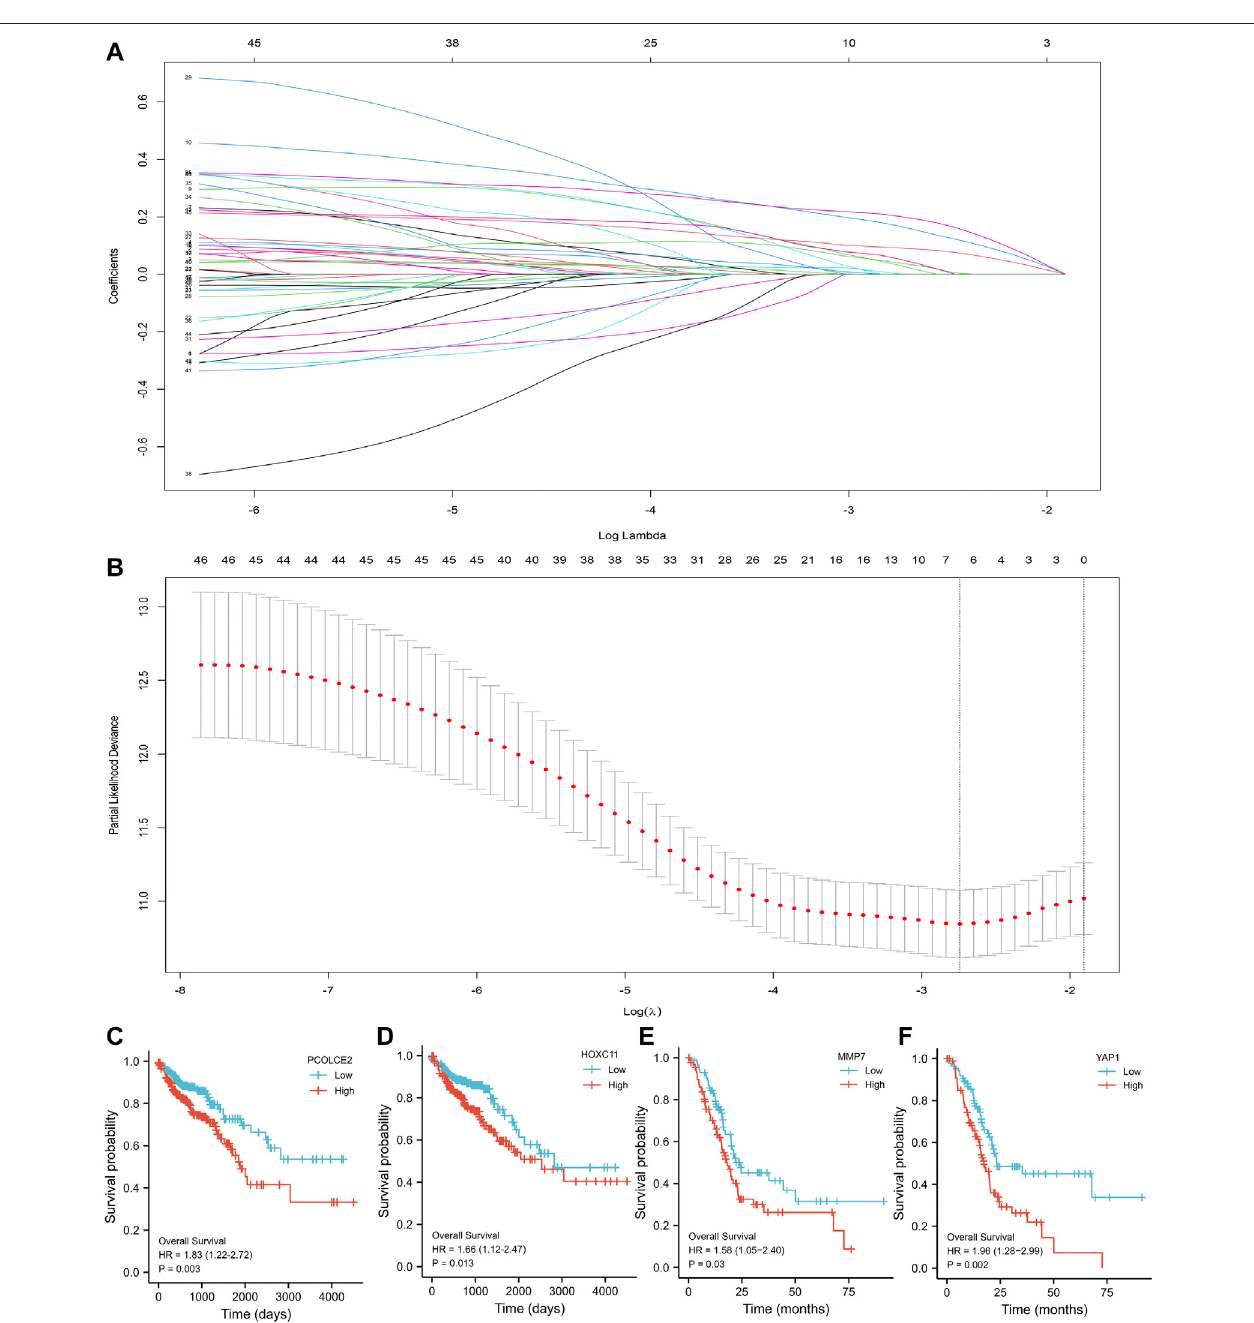
FIGURE3 | Screening ofkey variables byLasso-Cox regression. Screening ofthe keyvariables associatedwithinvasionand metastasis byLasso-Cox regression (A) ; Variable analysis by Lasso regression correction (B) ; Kaplan – Meier survival analysis of COAD patients with high and low expression of PCOLCE2 (C) , HOXC11 (D) , MMP7 (E) , YAP1 (F) . p value was statistically signi fi cant, HR > 1.5.